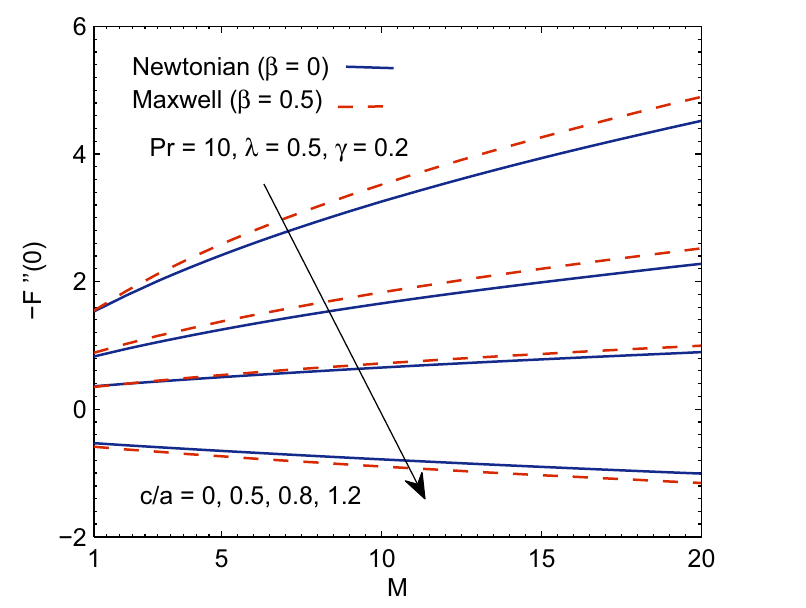
Fig 10. Profiles of − F @ (0)for various parametric